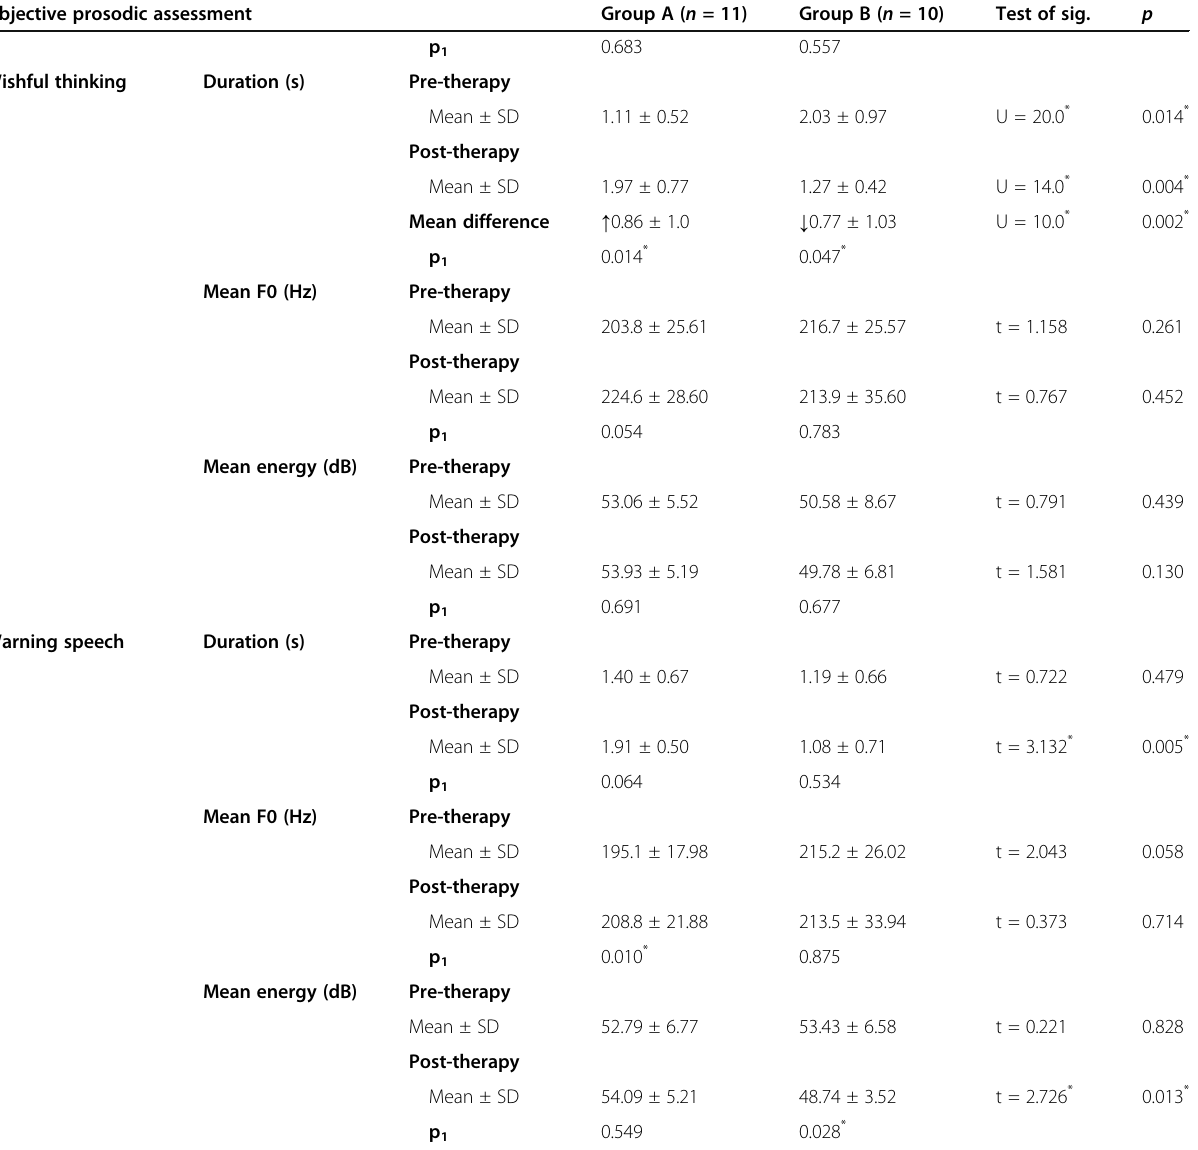
Table 6 Comparison between the two studied groups according to objective prosodic assessment